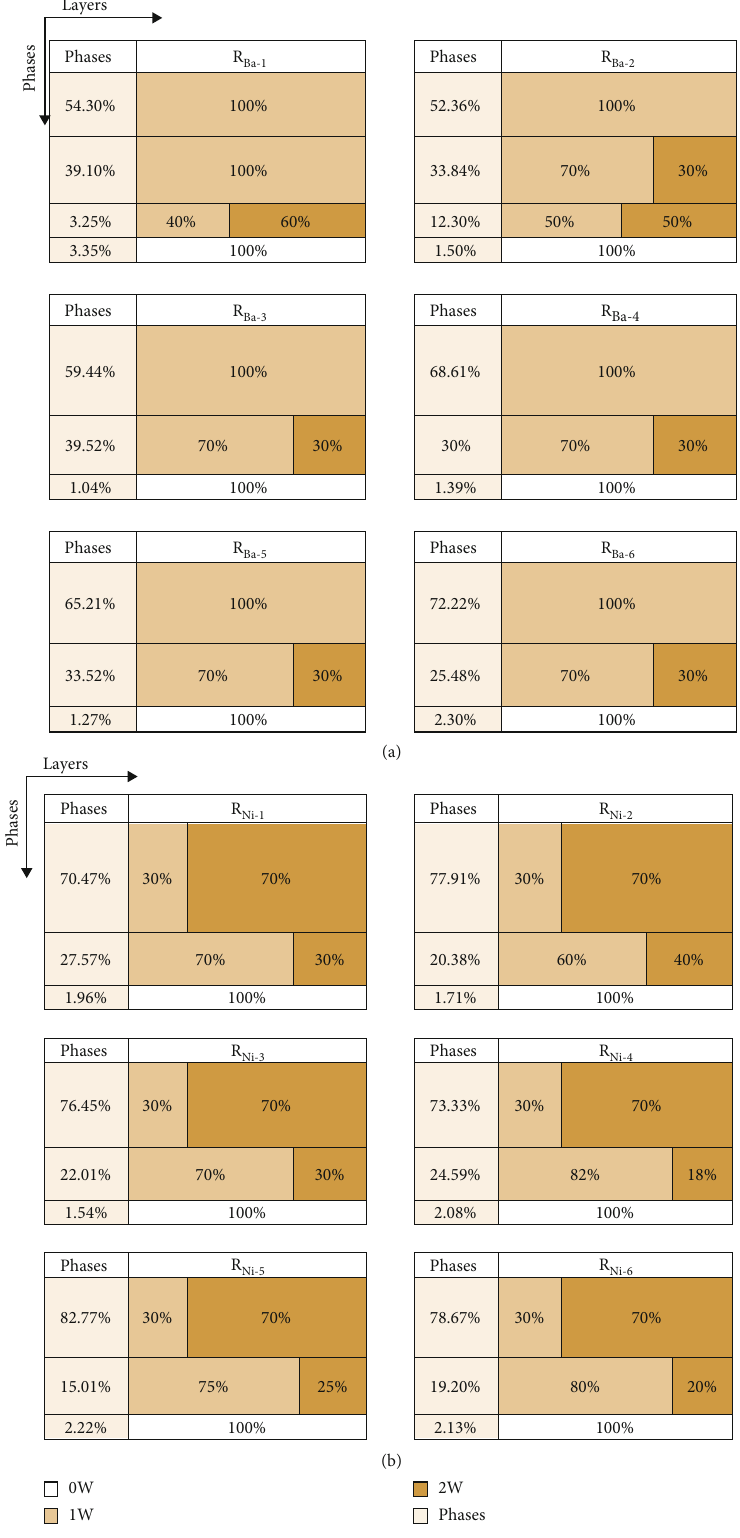
Figure 4: Graphic Representation of the hydration state in the case of SWy-Ba (a) and SWy-Ni (b) samples via modelling of X-ray di ff raction. Colors white, light-brown, and dark-brown represent the type 0 W , 1 W , and 2 W layer hydration states, respectively. Each line thus represents a layer with his own hydration state. The con fi guration considered here is extracted from validated MLS and based on 100 layers per